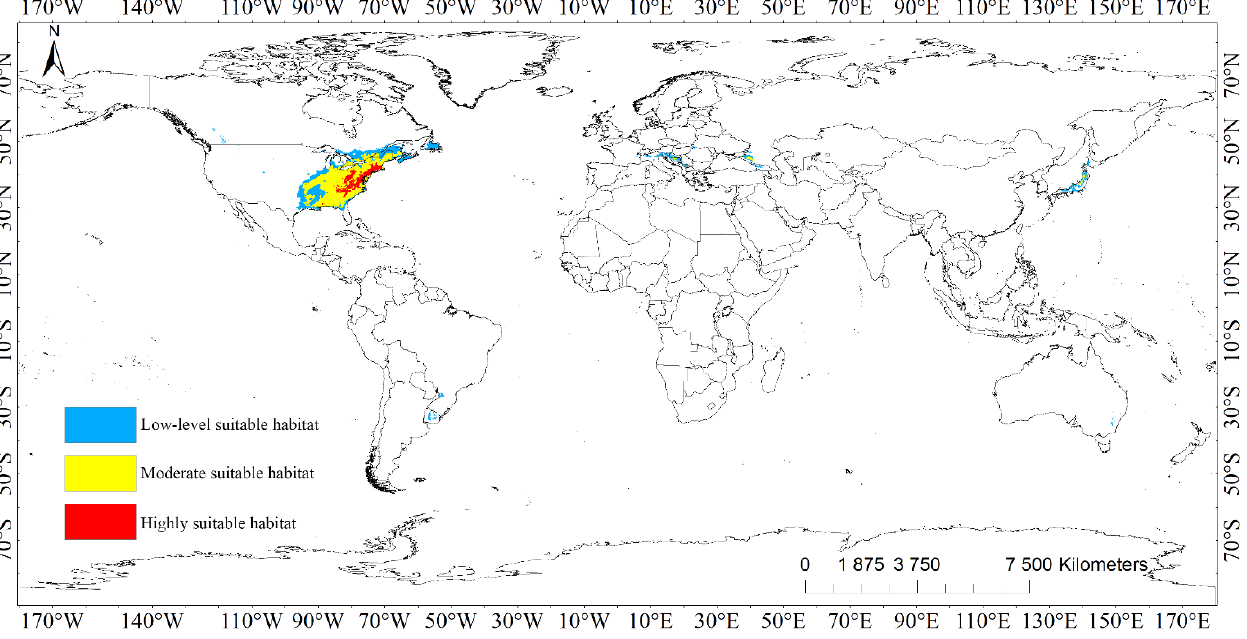
Figure 2. Population distribution of Liriodendron tulipifera under current scenario. Table 3. Current distribution area of Liriodendron tulipifera.